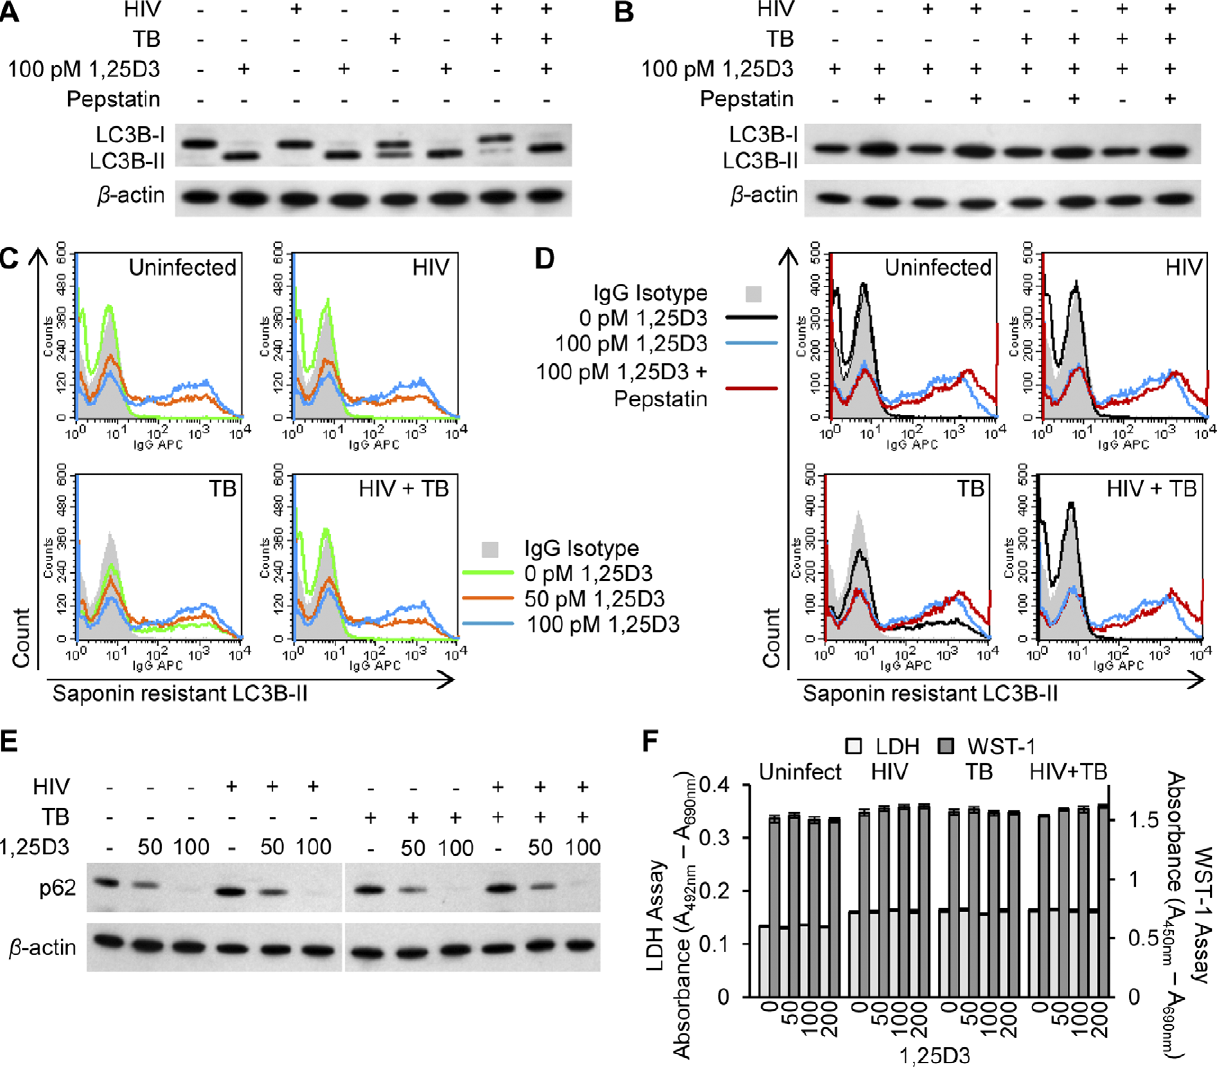
Figure 2. 1,25D3 induces autophagy in human macrophages co-infected with HIV and M.tuberculosis . HIV and/or M. tuberculosis (TB) infected MDM were treated for 7 days with 100 pmol/L 1,25D3. (A) Cells were lysed and immunoblots of LC3B isoforms using antibody to LC3B or b - actin performed. (B) Cells were incubated with 10 m g/mL pepstatin A for 4 h on day 7 prior to lysis. Immunoblots of LC3B isoforms using antibody to LC3B or b -actin. (C) Flow cytometry analysis of saponin-resistant LC3B-II in macrophages after 1,25D3 treatment for 7 d. Representative histograms of cells displaying saponin-resistant LC3B-II from three donors are shown. (D) Flow cytometry analysis of saponin-resistant LC3B-II in macrophages after 1,25D3 treatment for 7 d followed by 10 m g/mL pepstatin A for a further 4 h. Representative histograms of cells displaying saponin-resistant LC3B-II from three donors are shown. (E) Immunoblots of p62 using antibody to p62 or b -actin 7 d after macrophages treated with 1,25D3. (F) At 7 d post- infection, aliquots of supernatant taken before the addition of WST-1 were tested for lactate dehydrogenase (LDH) spectrophotometrically using the LDH PLUS assay. For the last hour cells were incubated with WST-1, and the reduction of the WST-1 reagent to its formazan product was monitored